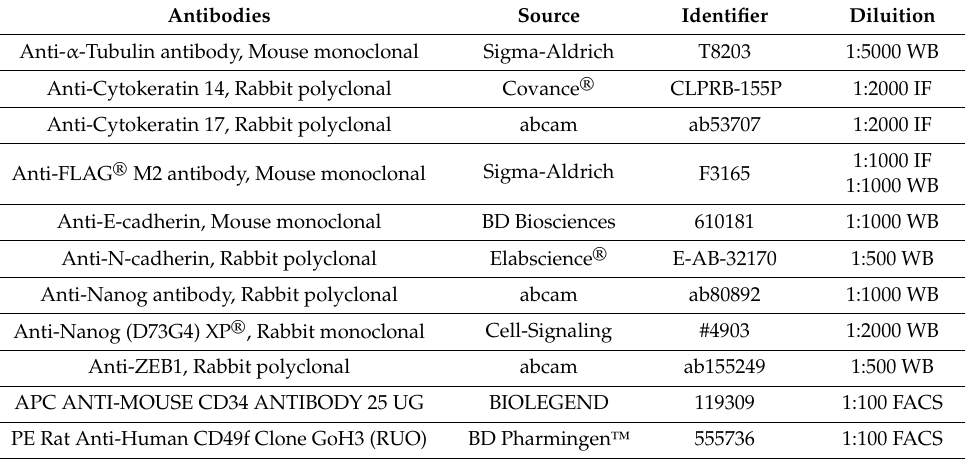
Table 1. List of antibodies used for molecular